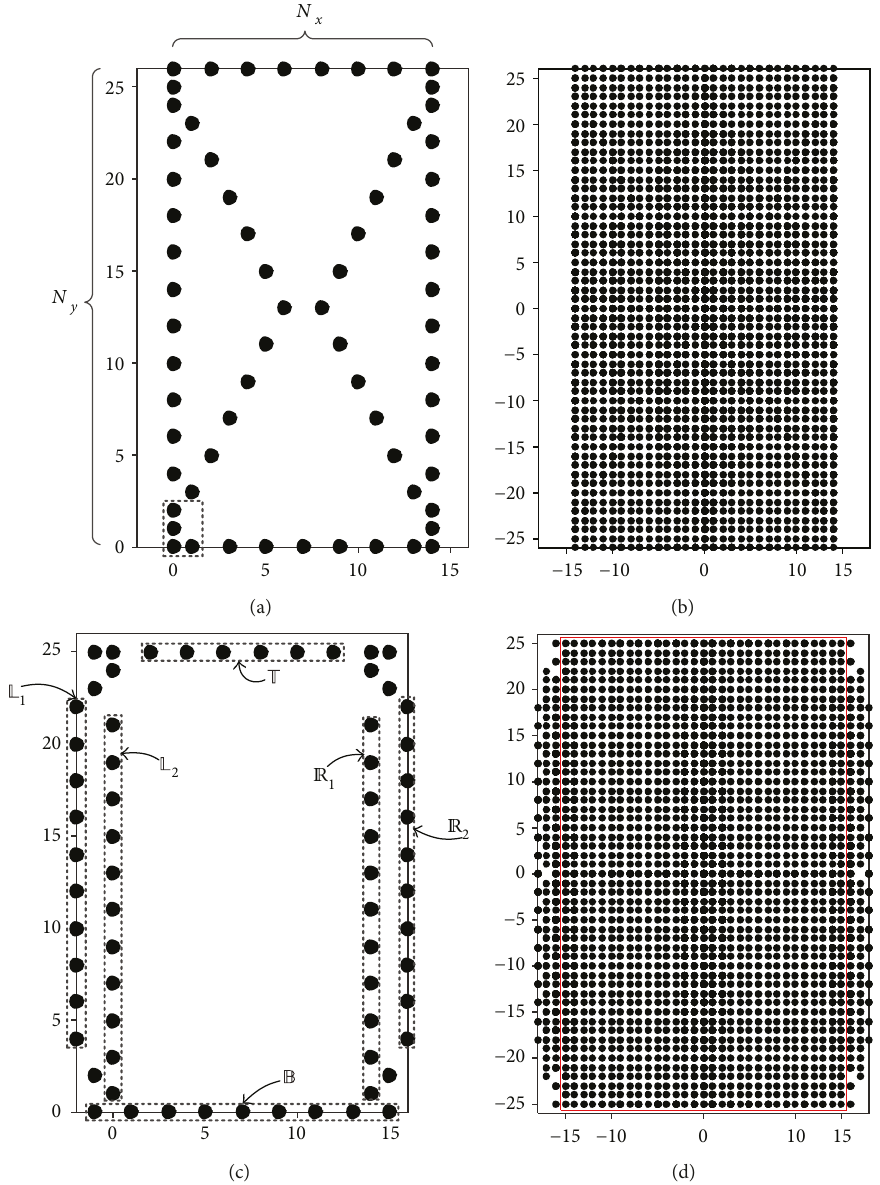
N x = 15 and y = 27 , and the